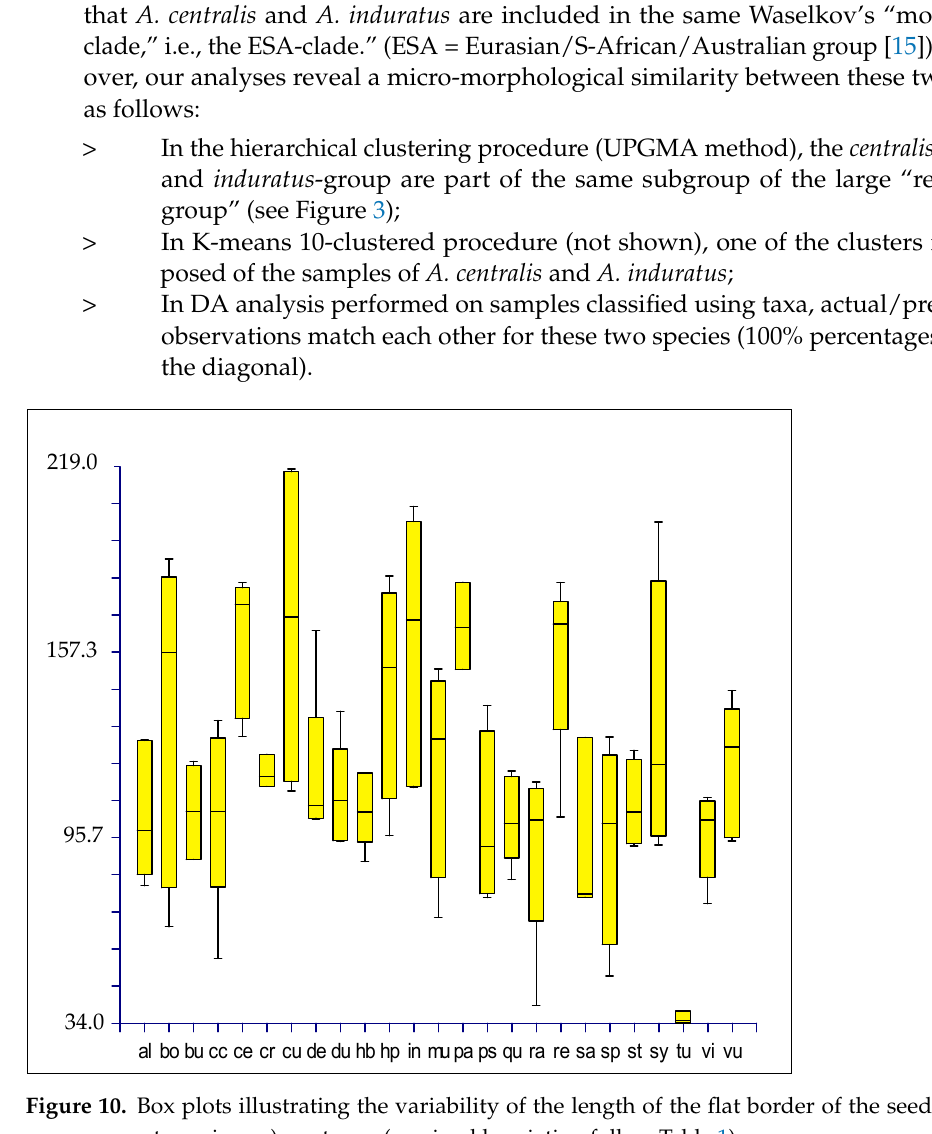
Figure 11. Box plots [characters ( y -axes) per “molecular clades” ( x -axes)] illustrating the variability of the length of flat border opposite to hilum (left graph), length of seed (central graph), and width of seed (right graph) (measurements are in µm). Abbreviation: D/P = Dioecius / Pumilus -clade; ESA = Eurasian/South African/Australian -clade; G = Galápagos -clade; SA = South American -clade; H = Hy- bridus -clade [clades according to Waselkov et al. [15] (pag. 446, Figure 1A].